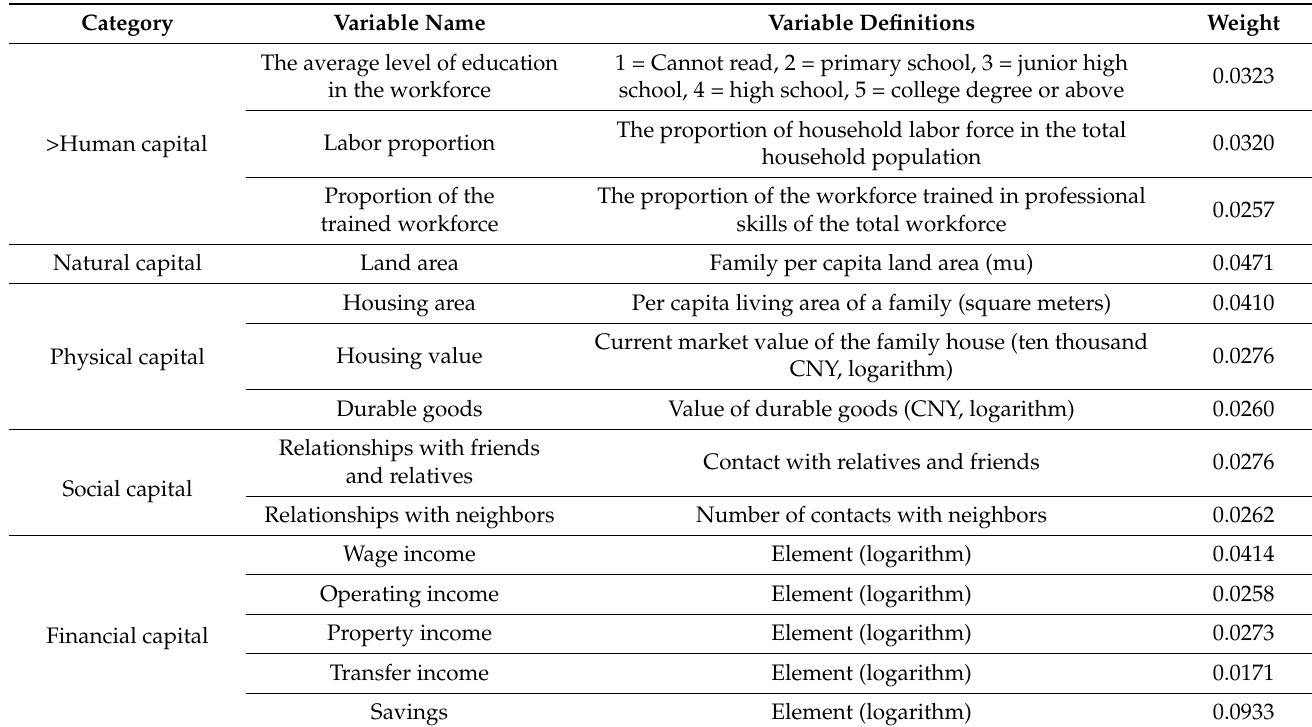
Table 1. Sustainable livelihood indicator system and